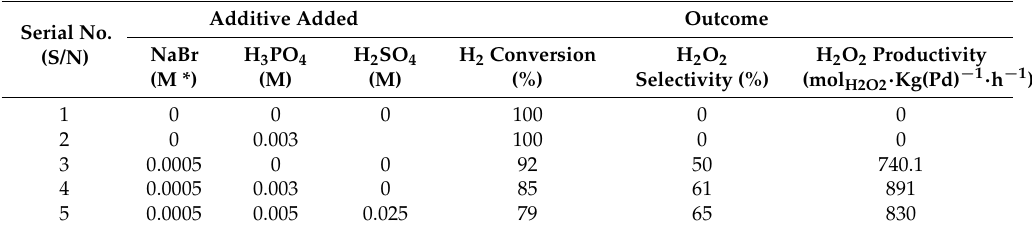
Table 3. Effect of different promoters on H 2 conversion, H 2 O 2 selectivity, H 2 O 2 productivity as reported by Gallina et al.